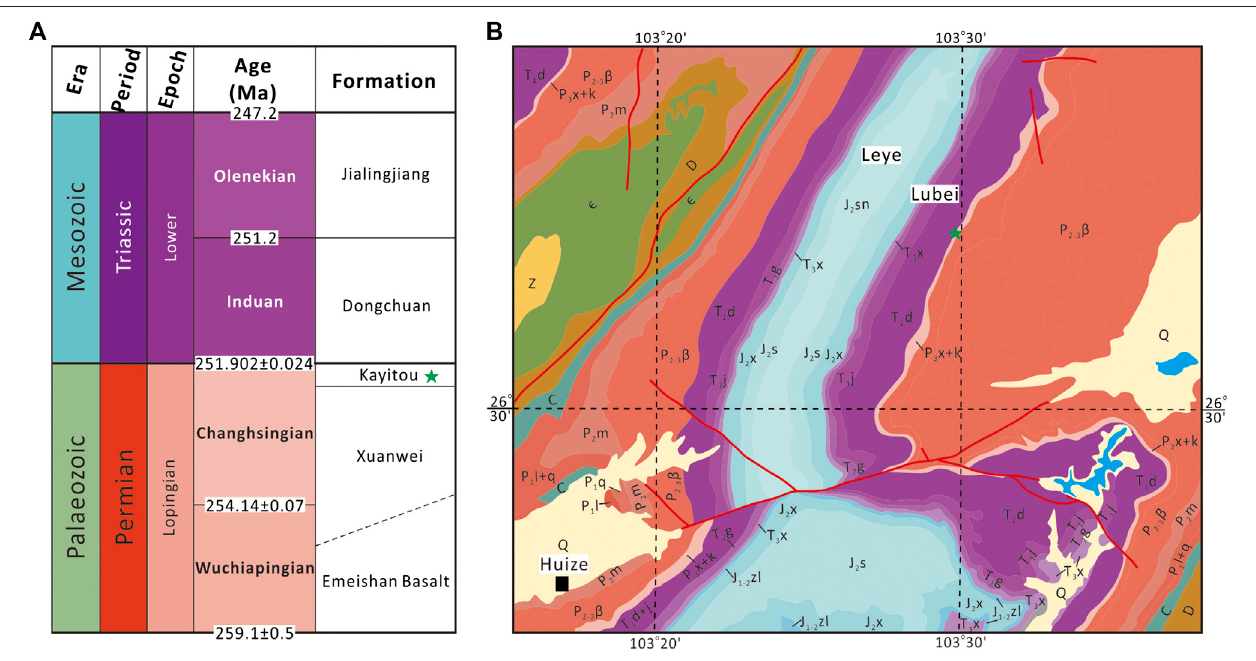
FIGURE 2 | Geological sequences (A) and geological map (B) of the Lubei section (asterisk) in northern Yunnan Province, Southwest China. Z, Neoproterozoic; ϵ , Cambrian; D, Devonian; C, Carboniferous; P 1 l, Lower Permian Liangshan Formation; P 1 q, Lower Permian Qixia Formation; P 2 m, Middle Permian Maokou Formation; P 2-3 β , Middle – upper Permian Emeishan Basalt; P 3 x, Upper Permian Xuanwei Formation; P 3 k, Upper Permian Kayitou Formation; T 1 d, Lower Triassic Dongchuan Formation; T 1 j, Lower Triassic Jialingjiang Formation; T 2 g, Middle Triassic Guanling Formation; T 3 x, Upper Triassic Xujiahe Formation; J 1-2 zl, Lower – Middle Jurassic Ziliujing Formation; J 2 x, Middle Jurassic Xiashaximiao Formation; J 2 s, Middle Jurassic Shangshaximiao Formation; J 2 sn, Middle Jurassic Suining Formation; Q,